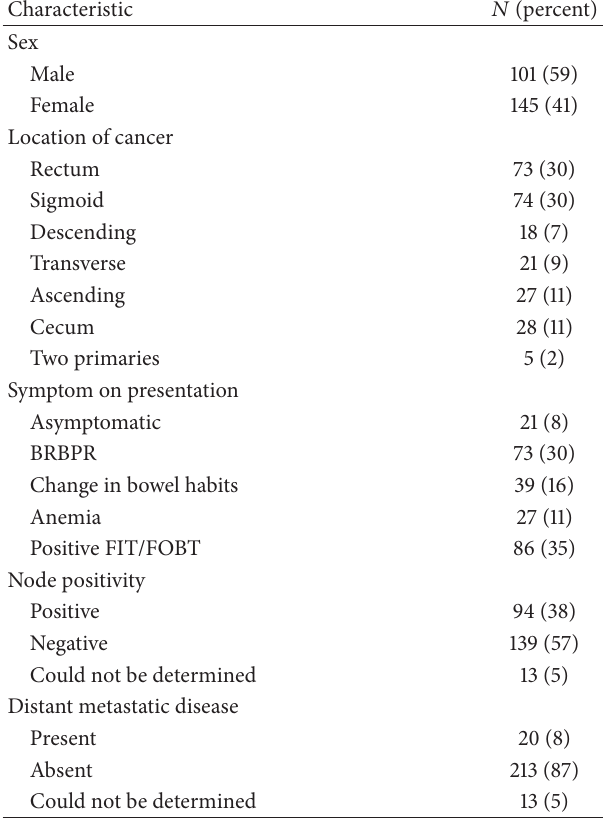
Table 1: Summary of patient and cancer characteristics for included subjects. The majority of patients were male. The majority of patients had alarm symptoms at the time of referral to the SPH gastroenterologists. The location of cancer was distal in 60% of patients, with either CRC in the rectum or sigmoid colon on surgical pathology. Most patients had no evidence of local nodal invasion (as determined by pathology) and no evidence of distant metastatic disease (as determined by imaging) at the time of